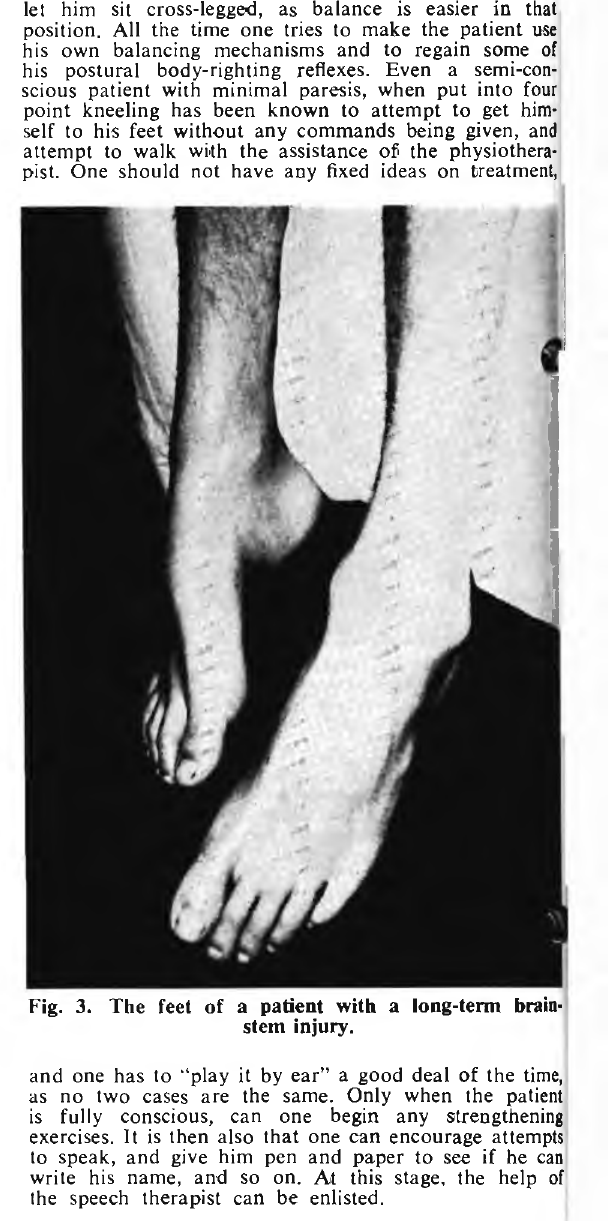
Fig. 3. The feet of a patient with a long-term brain­ stem